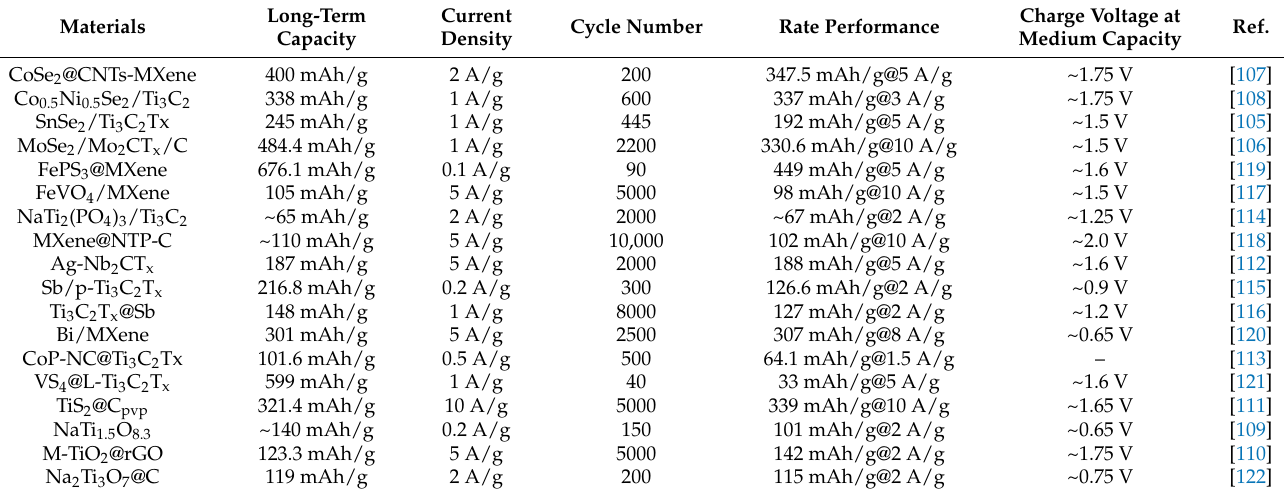
Table 5. Comparison of the performance values of different anode materials in